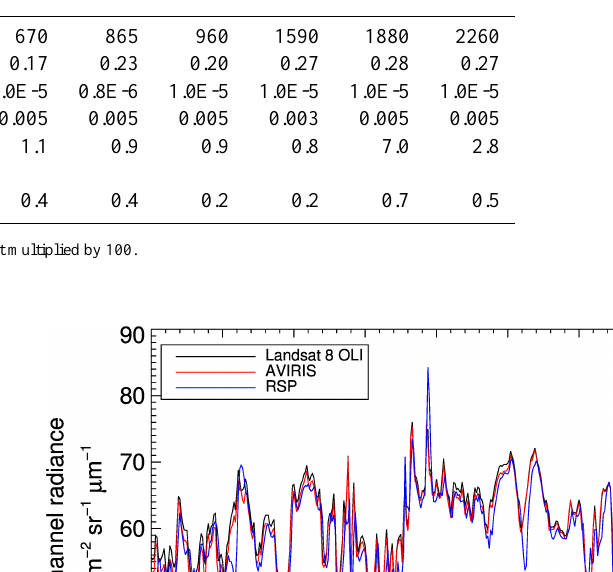
Table 1. Uncertainties in dark reference determination, contamination of dark reference by scene radiance, radiometric gain and nonlinearity in response.